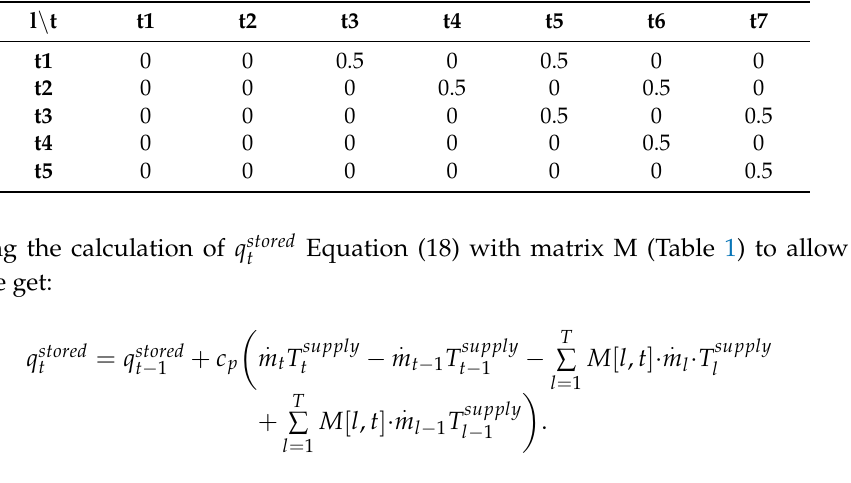
Table 1. Matrix M showing time delay and share of consumption.